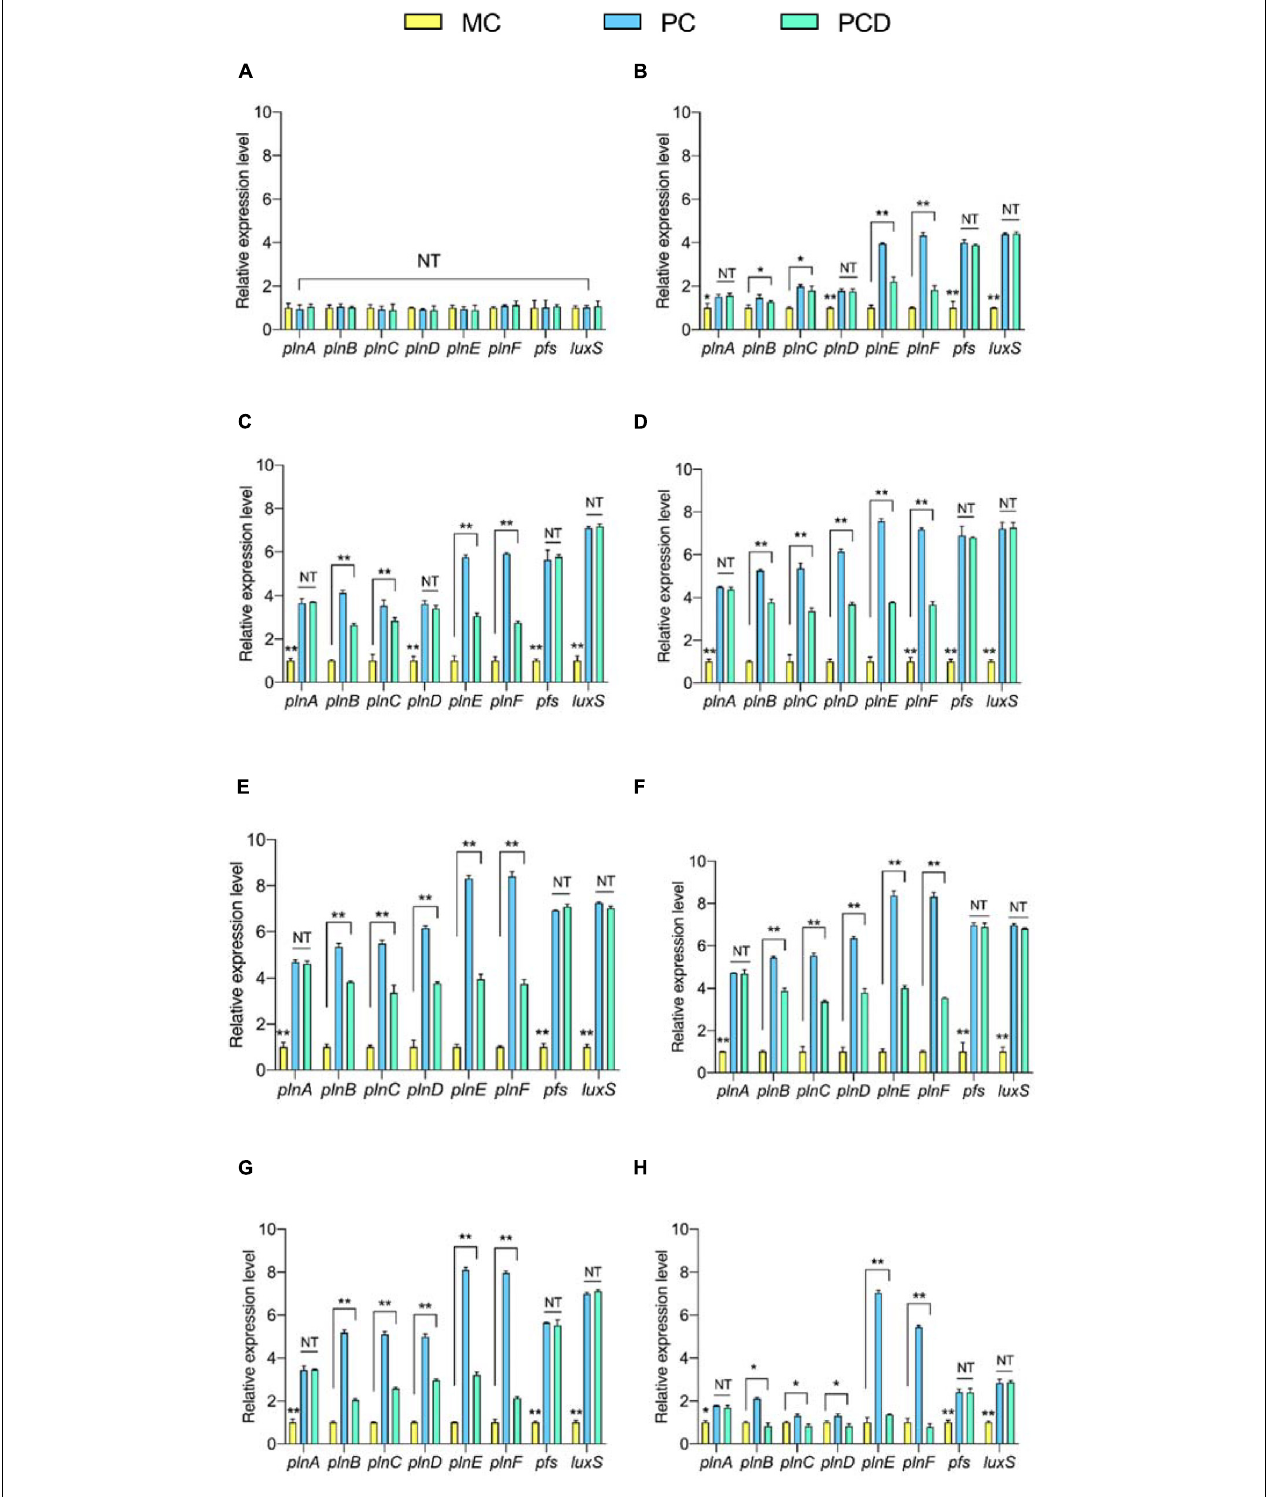
FIGURE 7 | The relative transcriptional levels of genes plnABCDEF , pfs , and luxS at 4 h (A) , 8 h (B) , 12 h (C) , 16 h (D) , 20 h (E) , 24 h (F) , 28 h (G) , and 32 h (H) , respectively. The yellow bar (left) means MC of L. plantarum RX-8 (10 6 CFU/ml) without B. subtilis BS-15 at 37 ◦ C in 4 ∼ 32 h, the blue bar (middle) means PC, of positive bacteriocin-inducing co-culture of L. plantarum RX-8 and B. subtilis BS-15 (10 6 :10 6 CFU/ml) at 37 ◦ C in 4–32 h, and the green bar (right) means PCD, PC with 200 mM D-ribose. NT indicates that there were no significant differences in the results of the control; * p < 0.05 and ** p < 0.01.